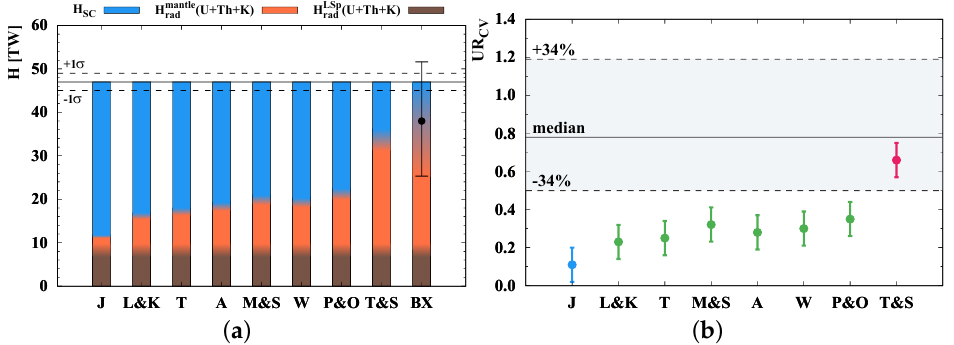
Figure 19. ( a ) Decomposition of the Earth’s total surface heat flux H tot = ( 47 2 ) TW (horizontal ± black lines) into its three major contributions: lithospheric radiogenic heat H LSp (brown), mantle rad radiogenic heat H mantle (orange), and secular cooling H SC (blue). The labels on the x axis identify rad different BSE models, while the last bar labeled BX represents the Borexino measurement. The lithospheric contribution is the same for all bars. ( b ) Comparison of Borexino constraints (horizontal band) with predictions of the BSE models (points with 3 σ error bars) for the convective Urey ratio ± UR CV (Equation (21)), assuming the total heat flux H tot = ( 47 2 ) TW. The blue, green, and red colors ± represent different BSE models (CC, GC, and GD, respectively). From